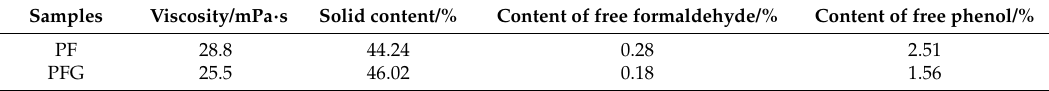
Table 2. Performance of phenol-formaldehyde resin modified by glutaraldehyde. Samples